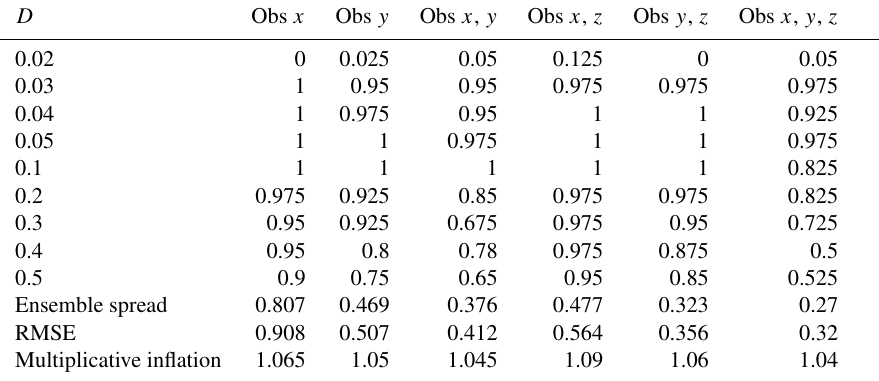
Table B1. Rates of successful control out of 40 CSEs with different observing coverage. T = (cid:100) 4 T 0 (cid:101) and perturbations are added to variables x , y , and z